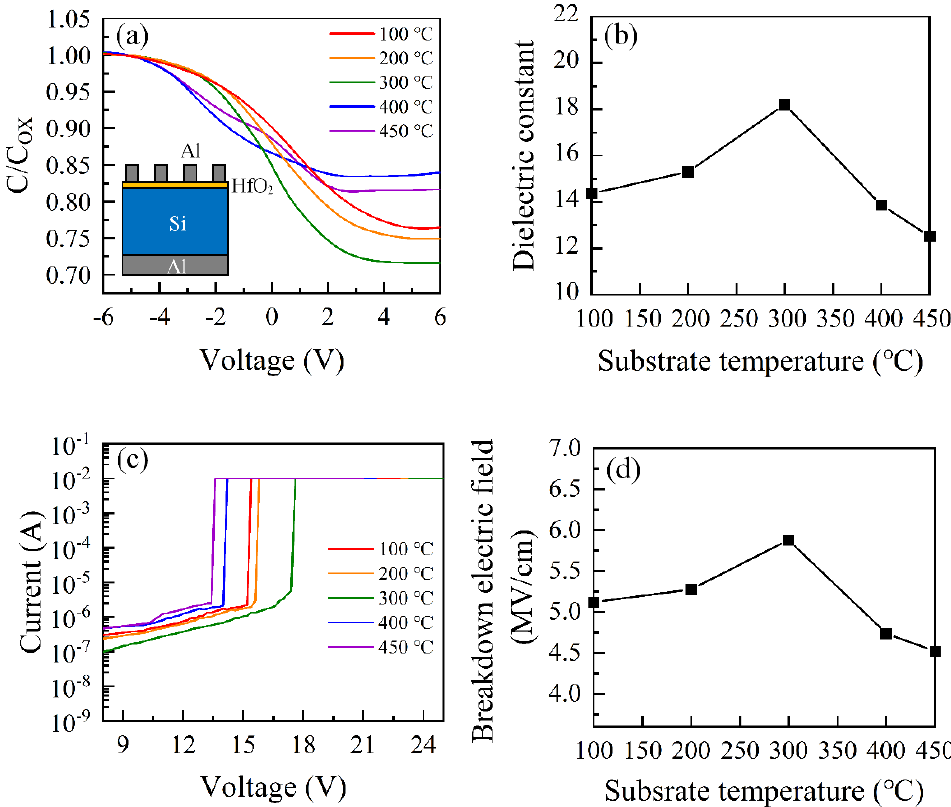
Figure 5. ( a ) C-V behavior of HfO 2 MOS capacitors. ( b ) The extracted dielectric constant as a function of substrate temperature. ( c ) I-V curves of HfO 2 MOS capacitors. ( d ) The breakdown electric field of the HfO 2 MOS capacitor according to substrate temperature.